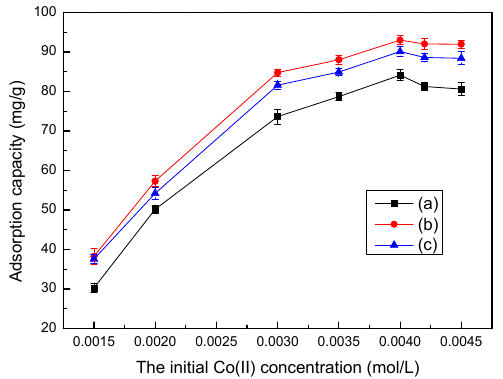
Figure 11. Effects of the initial Co(II) concentration on adsorption by LMT at various temperatures: 70 ◦ C, 75 ◦ C, and 78 ◦